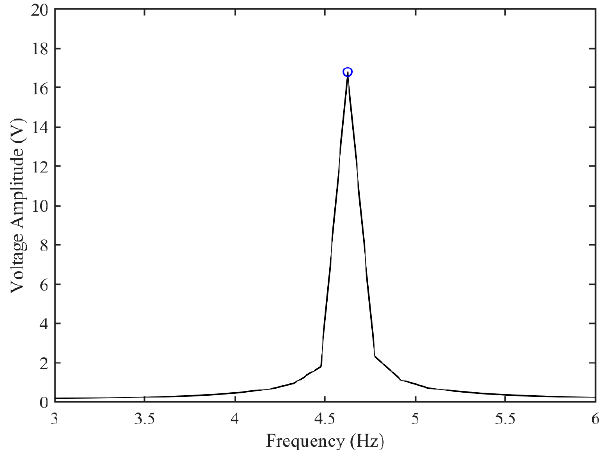
Figure 11. Time–history displacement response ( U = 1.8 m/s).